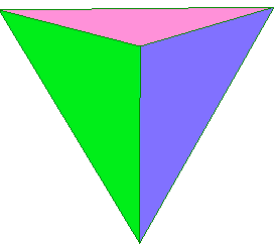
Figure 1. A primary zeolite building unit (the first stage in modeling the three-dimensional structure of zeolites) [compiled by the authors].